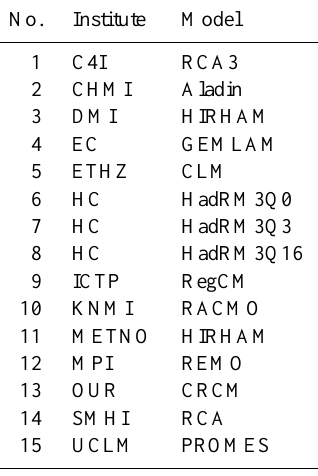
Table 3. ERA40-driven RCM experiments (1961–2000) with a res- olution of 25km from the ENSEMBLES EU project used in this